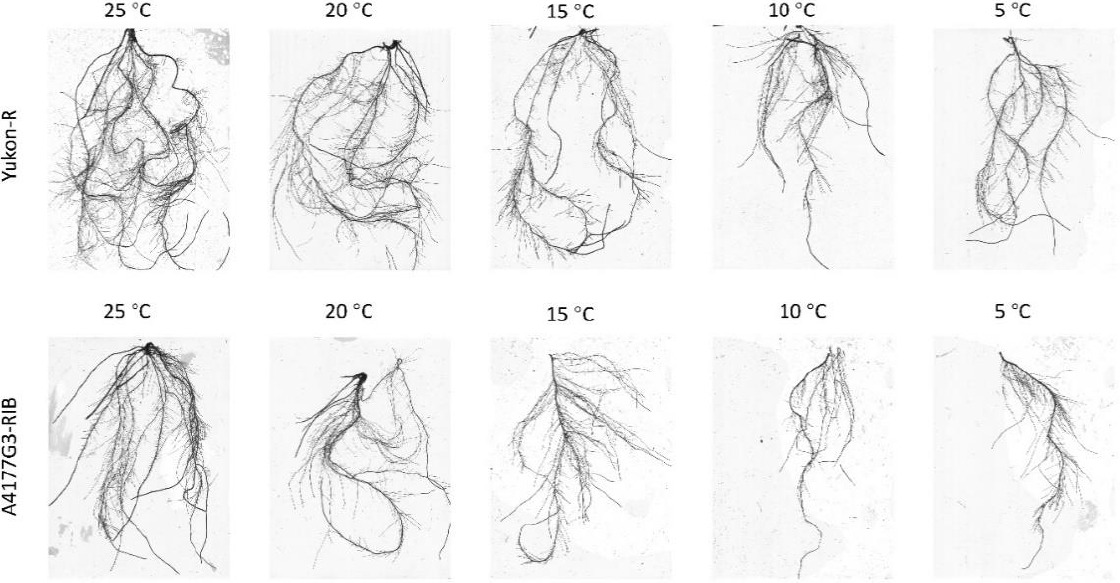
Figure 1. Effect of chilling temperature (5, 10, and 15 ◦ C) and non-chilling temperature (20 and 25 ◦ C) on silage corn seedling root growth. 3.2. Chlorophyll Content, Photosynthesis Rate, and Maximum Photochemical Efficiency of PS-II Growth temperatures had significant effects ( p < 0.001) on total chlorophyll content, and Chl b content on silage corn seedlings, whereas Chl a content is affected ( p < 0.001) by growth temperatures only (Figure 2A–E). However, the interactions between growth tem- peratures and silage corn genotypes had no effects on Chl a , Chl b , and total chlorophyll con- tents (data not shown). Significantly higher total chlorophyll (1687.62 ± 32.83 µ g g − 1 FW), at 25 ◦ C whereas the lowest values were recorded at 5 ◦ C (Figure 2A–C). Yukon-R